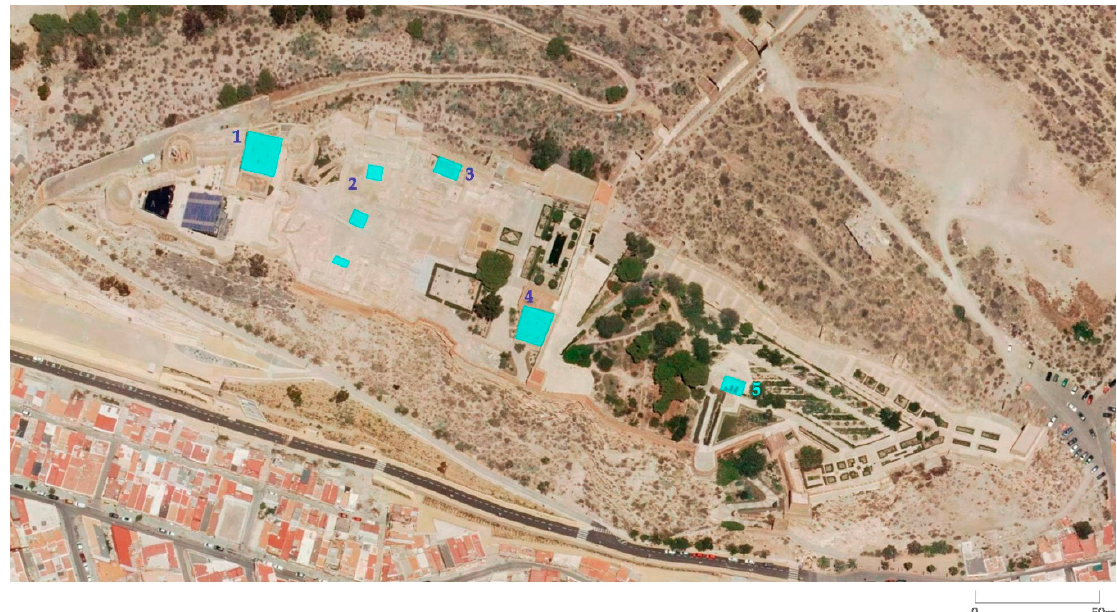
Figure 6. Alcazaba of Almería. Hillside terraces and hydraulic constructions: (1) Noria del Viento Tower, (2) the ponds of the palace, (3) the Baño de la Tropa ( ḥ amm ā m ), (4) the cistern next to Aljama mosque, and (5) the cistern on the lower terrace. Created by authors.